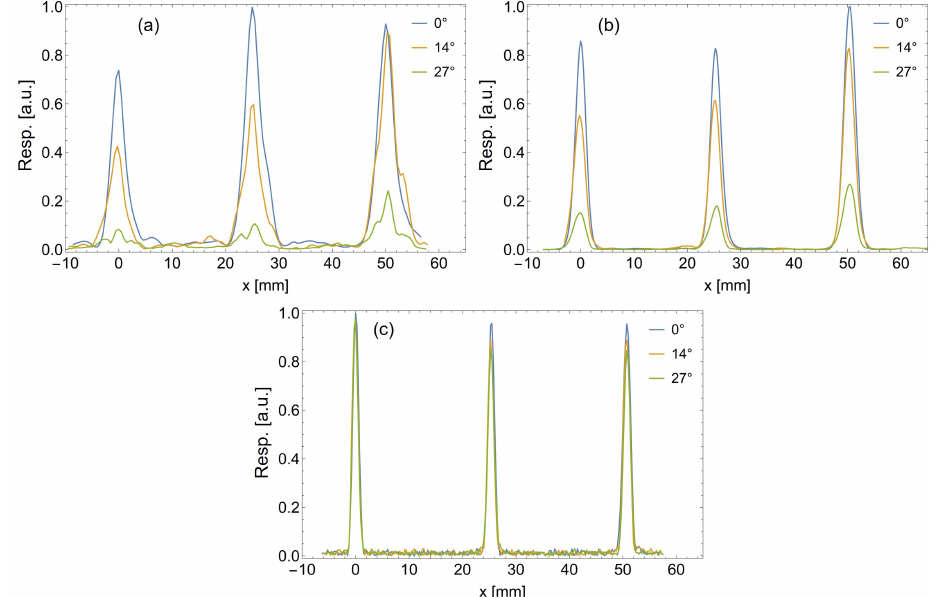
Figure 10. Cross sections along the spots measured in the focal plane of the f = 100 mm and ν = 260 GHz structure with ( a ) QOD, ( b ) WR34 and ( c ) FET detectors. The blue, orange and green lines denote the configurations with the detectors placed at an angle of 0 ◦ , 14 ◦ and 27 ◦ , respectively. These geometries reflect the situations in which the detectors face the center of the lens from the positions of M, L and 2L focal